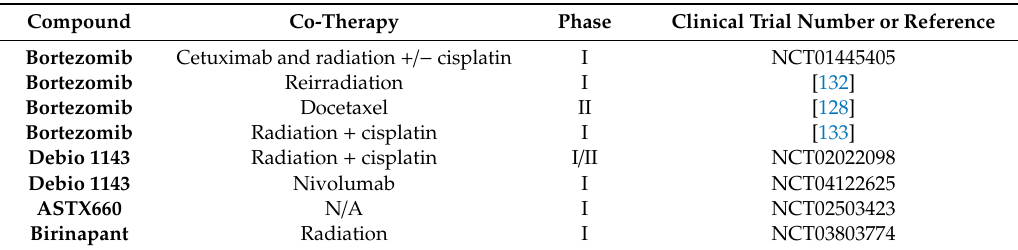
Table 3. Overview of clinical trials for ubiquitin-modulating compound for